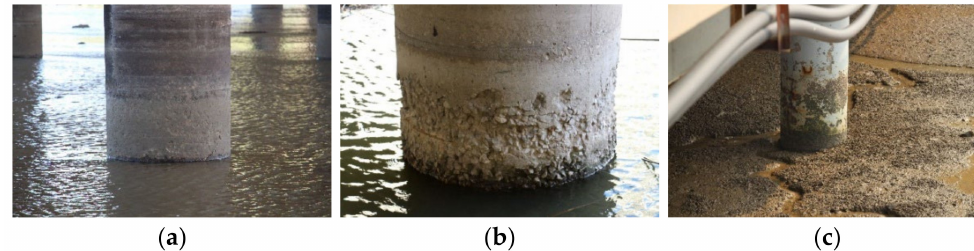
Figure 2. Destruction forms of RC piers after seawater freeze–thaw cycles. ( a ) Voids and pits. ( b ) Spalling. ( c )